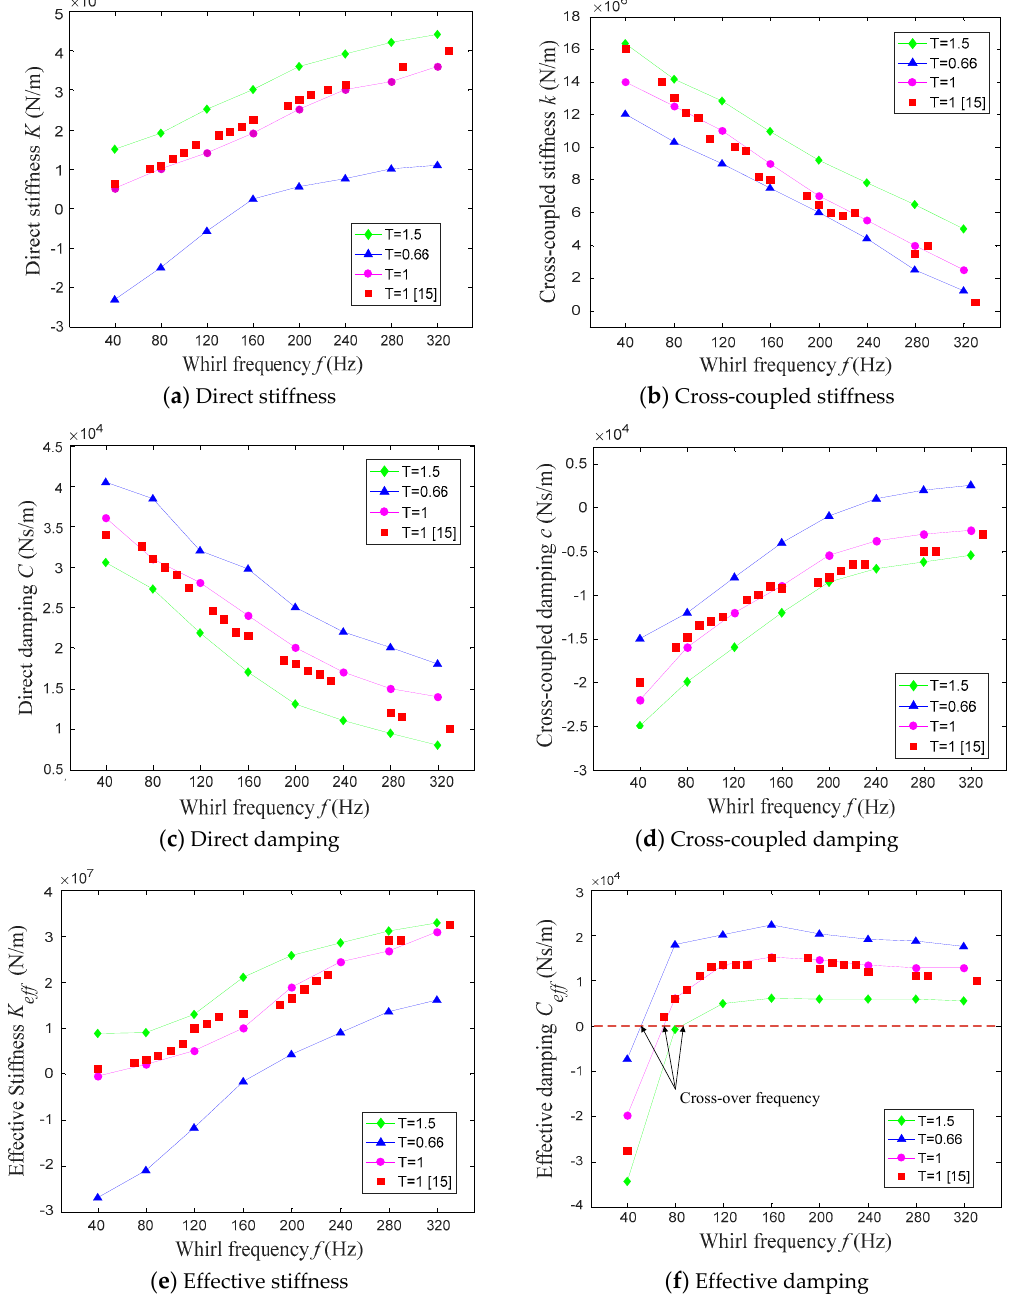
Figure 11. E ff ect of dynamic characteristics ( a – e ) of hole-pattern damper seals on whirl frequency, where N ( P inlet = 7 MPa, P outlet = 3.15 MPa, RS = 20,200 r / min, T inlet = 17.4 ◦